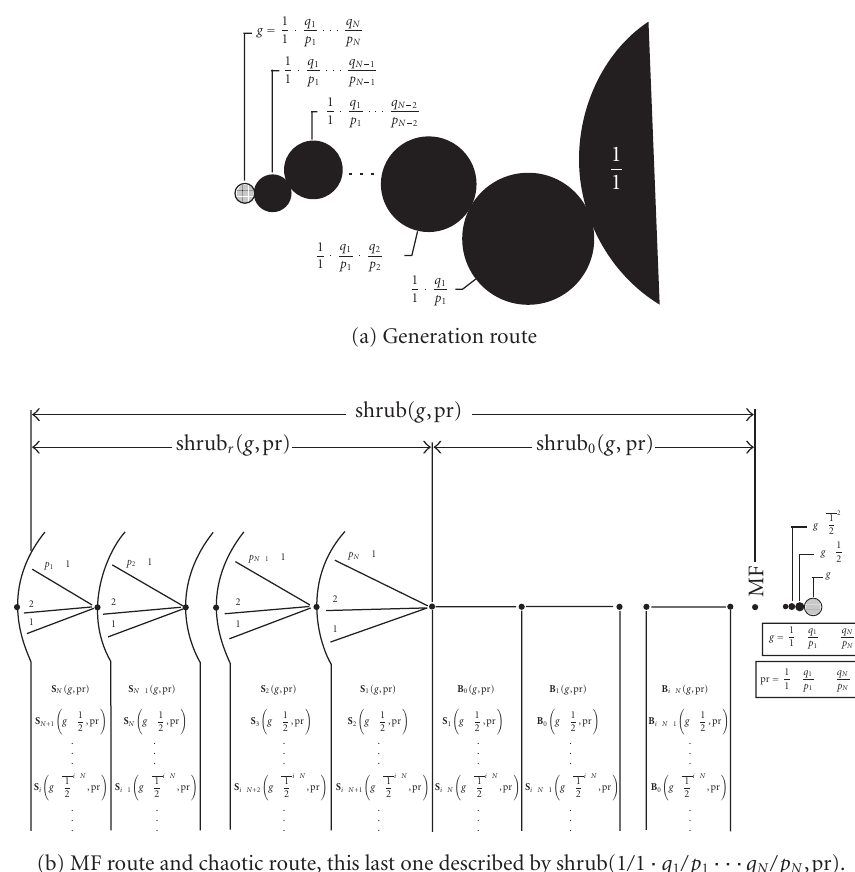
Figure 6.1. Sketch of the N -ary route through the N -ary hyperbolic component 1 / 1 · q 1 /p 1 ··· q N /p N